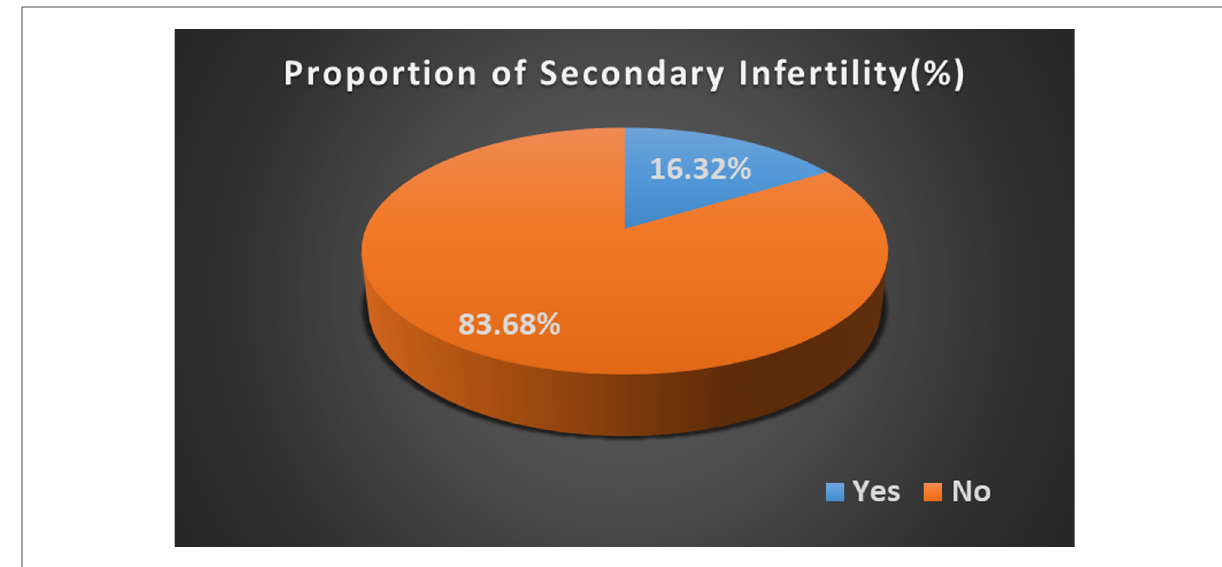
FIGURE 1 Prevalence of secondary infertility in East